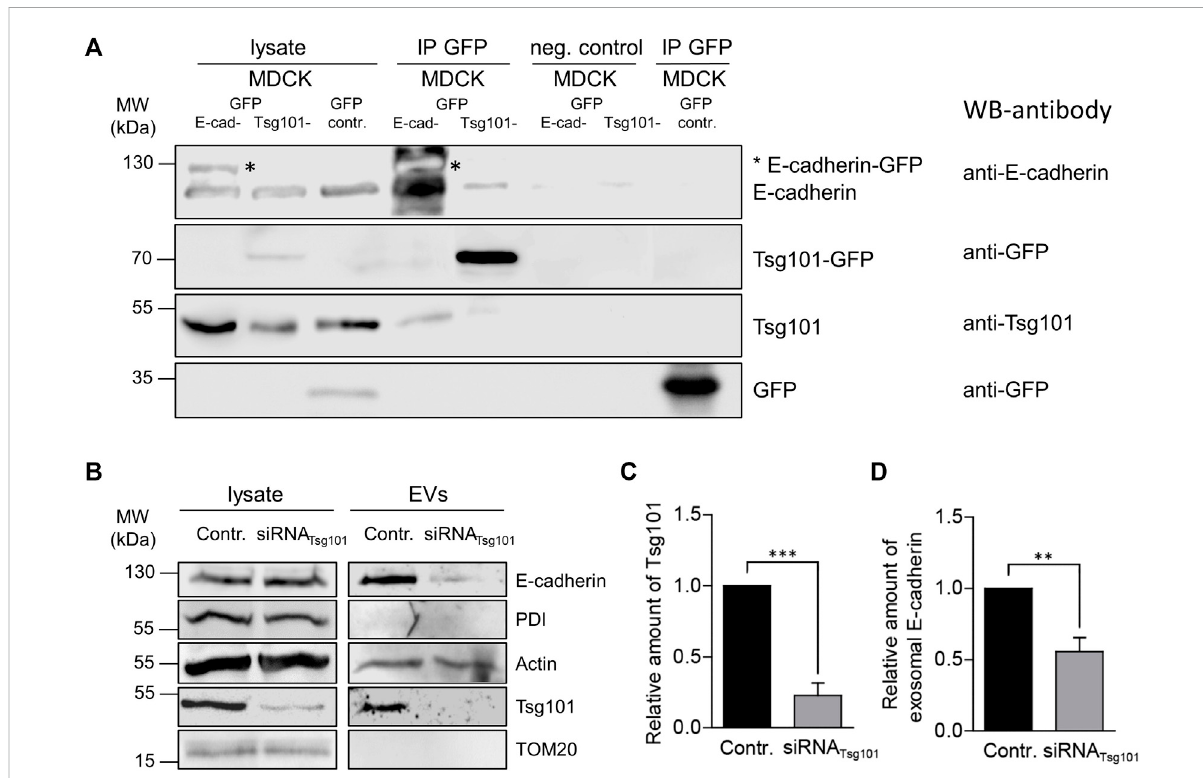
FIGURE 4 Tsg-101 dependent EV recruitment of E-cadherin. (A) Co-immunoprecipitation of E-cadherin-GFP or Tsg101-GFP from MDCK cell lysates. E-cadherin-GFP or Tsg101-GFP fusion proteins and their binding partners were immunoprecipitated with GFP-nanobody beads and detected by immunoblot using antibodies directed against E-cadherin, GFP and Tsg101. Non-speci fi c precipitation was monitored by using control beads without nanobodies (neg. control) and GFP from MDCK GFP cells (GFP-contr.). Antibodies used for western blots (WB) are